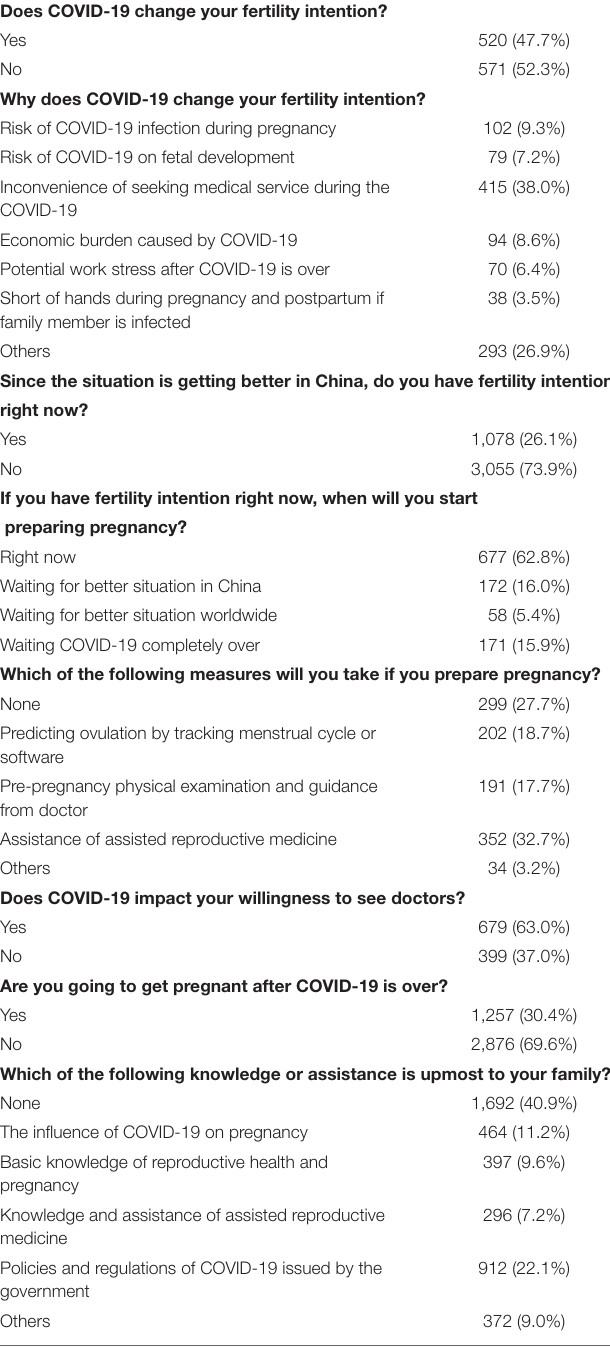
TABLE 4 | Attitudes toward COVID-19 of participants with fertility intention before COVID-19. Does COVID-19 change your fertility